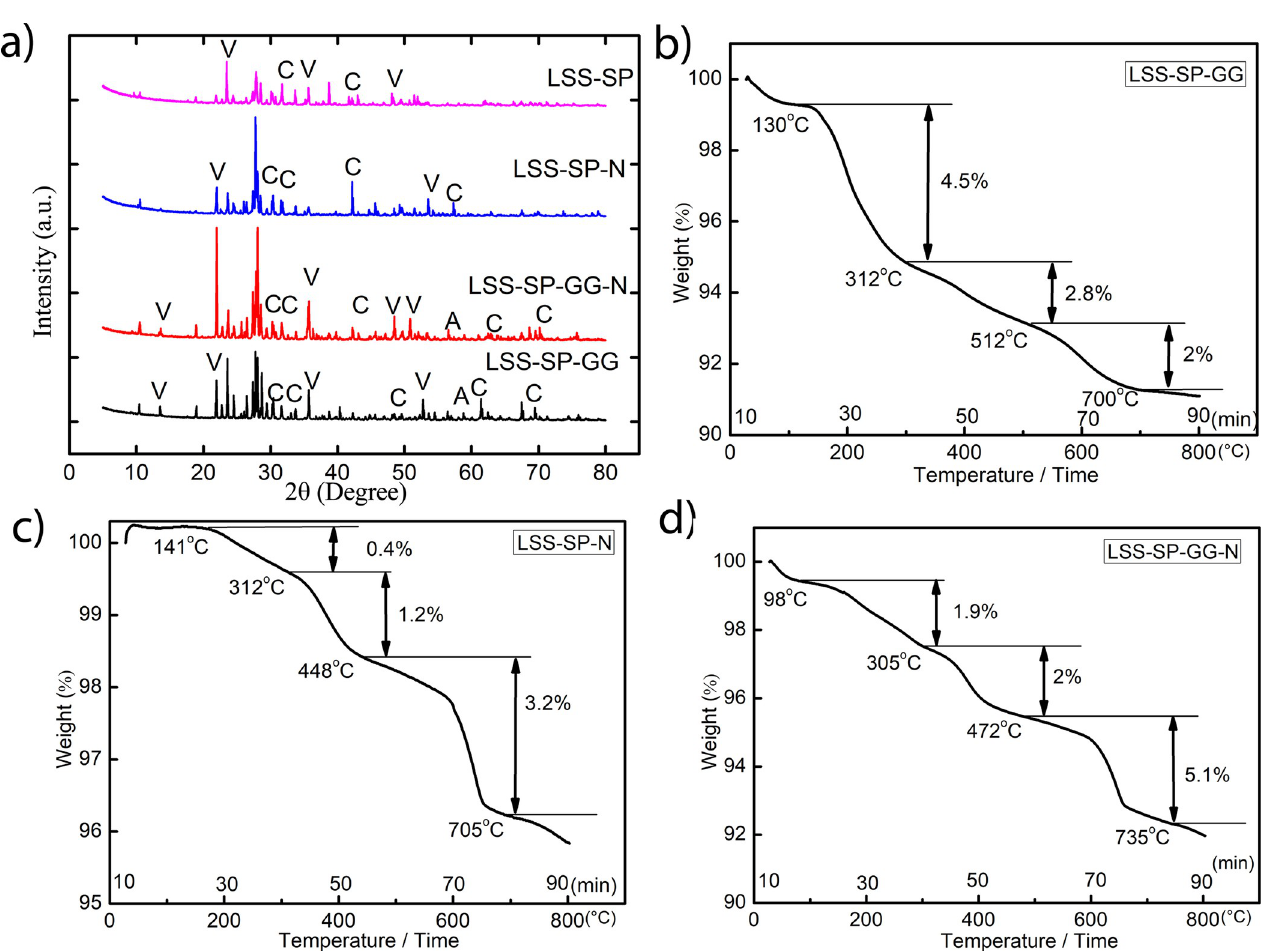
Fig 8. a) XRD pattern of consolidated lunar bricks with different treatments. (V–vaterite; C- calcite; A- aragonite). TG curves: b) LSS supplemented with guar gum and treated with S. pasteurii c) LSS supplemented with Ni and treated with S. pasteurii d) LSS supplemented with guar gum and Ni and treated with S.